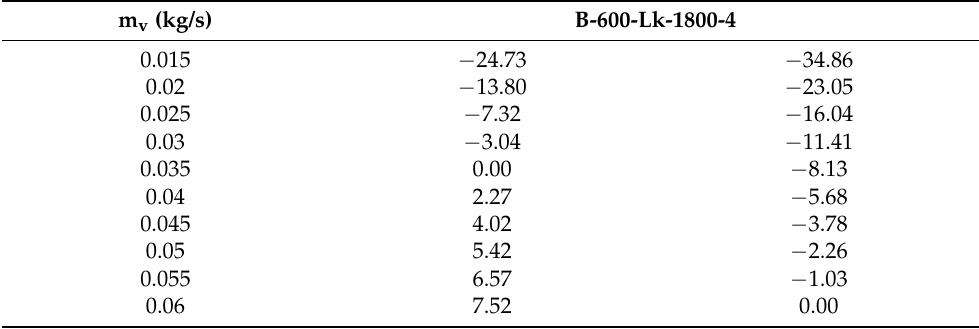
Figure 6. Dependence of cooling power on the rate of flow (t 11 = 16 ◦ C, T i = 25 ◦ C). Result of simulations comparing the percentage change in power with the change in flow for the temperature drop and the flow at which the cooling power of the convector was measured and the percentage change in cooling power related to the maximum power at flow 0.06 kg/s (Table 1). Table 1. Percentage changes in the cooling power for variations in the flow rate based on 100% power for Δ T = 7.5 K.